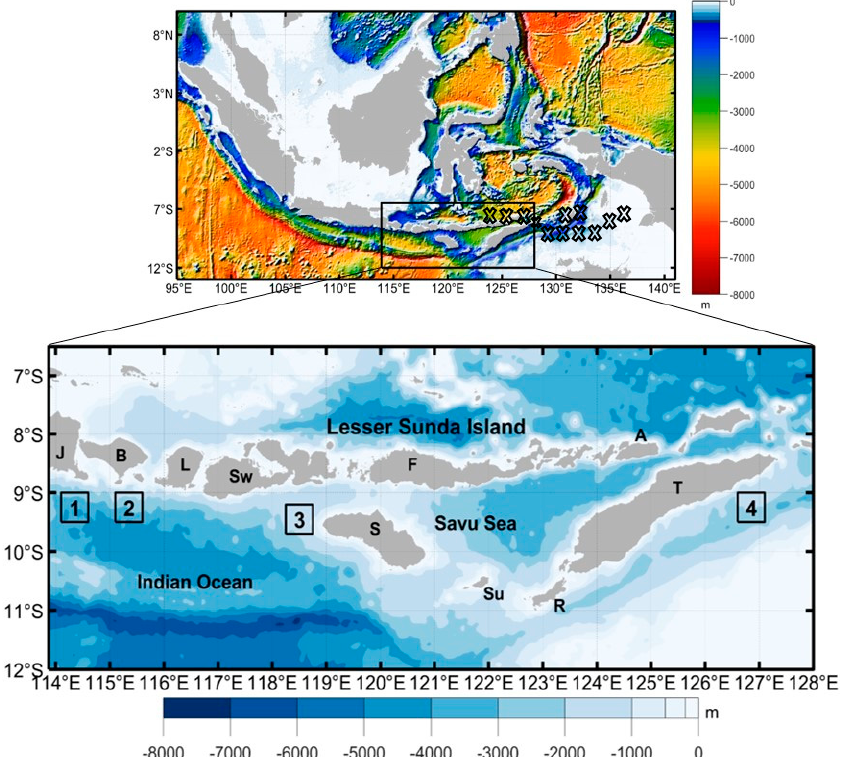
Figure 1. Map of the study site at the southern coast of Lesser Sunda Island. The names of islands (marked by alphabet letters) are Java (J), Bali (B), Lombok (L), Sumbawa (Sw), Flore (F), Alor (A), Sumba (S), Savu (Su), Rote (R), and Timor (T). The background color is the bathymetry depth. Black boxes are the specific study area for analyzing the correlation between sea surface temperature (SST) and wind.